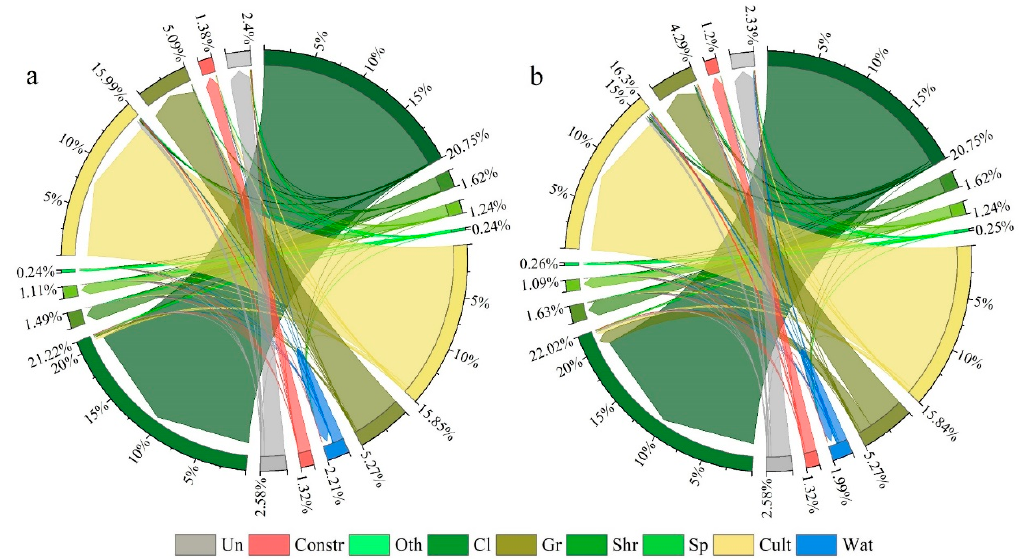
Figure 10. Future land use conversion relationship (( a , b ) represents 2030, 2050, respectively. The beginning of the arrow indicates the land proportion in the base year, and the arrow points to the land proportion in the target year).